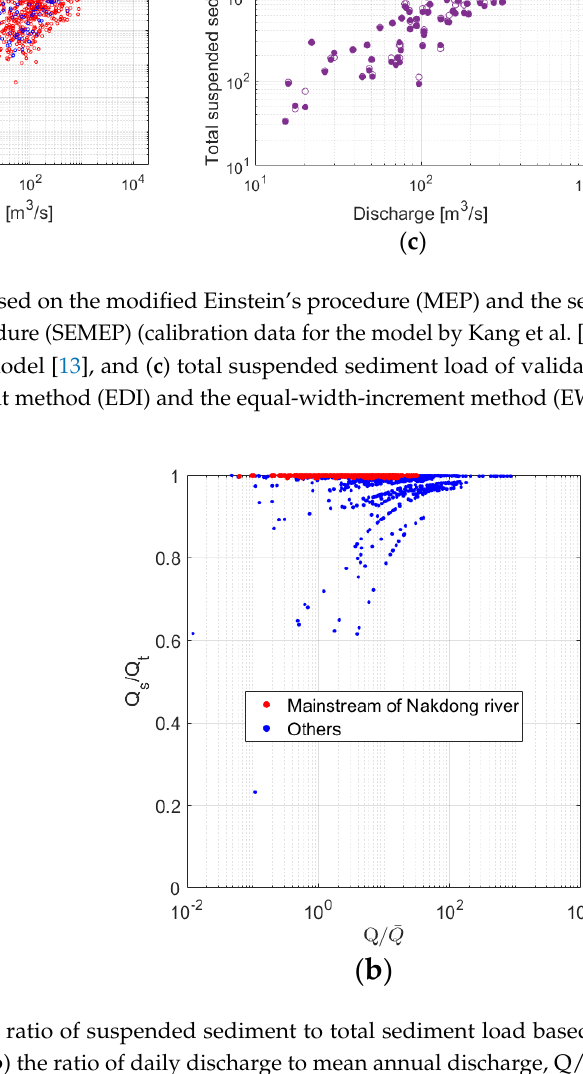
calibration data and ( a ) u ∗ / ω and ( b ) the ratio of daily discharge to mean annual discharge, Q/ Q .